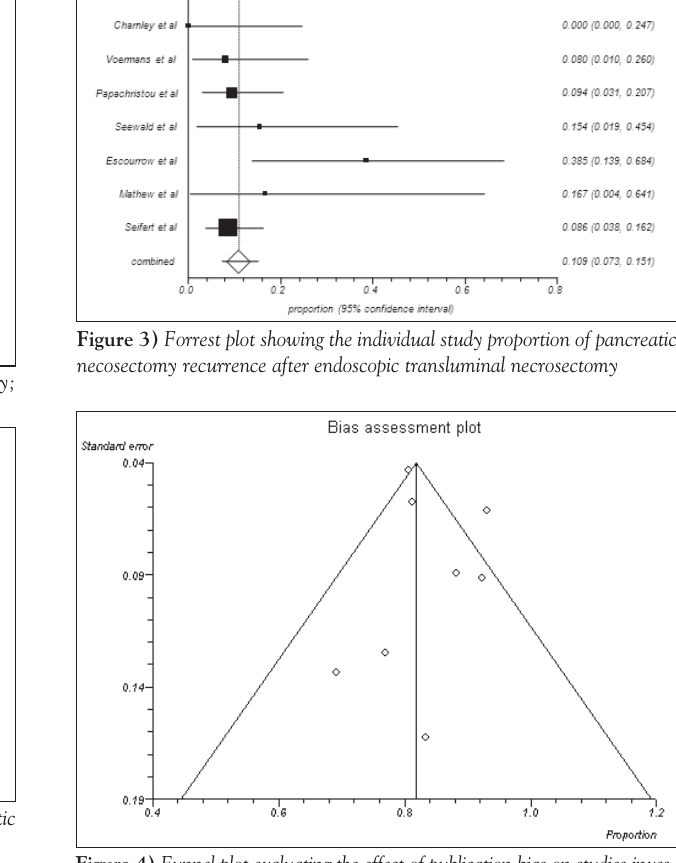
Figure 4) Funnel plot evaluating the effect of publication bias on studies inves- tigating endoscopic transluminal necrosectomy for walled-off pancreatic